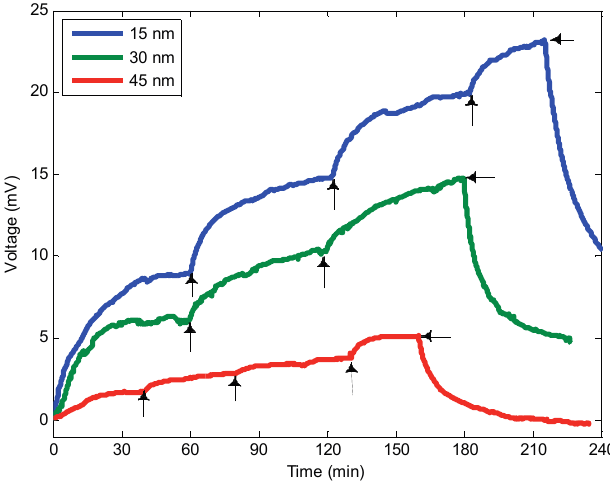
Figure 5. Response of the optical fiber sensors to different NO 2